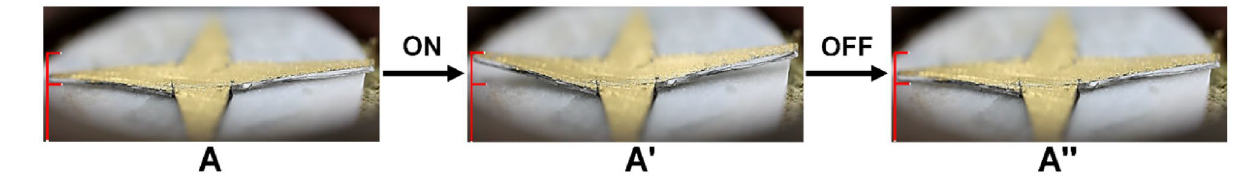
Figure 6. Snapshots of remote actuation by applying a rf